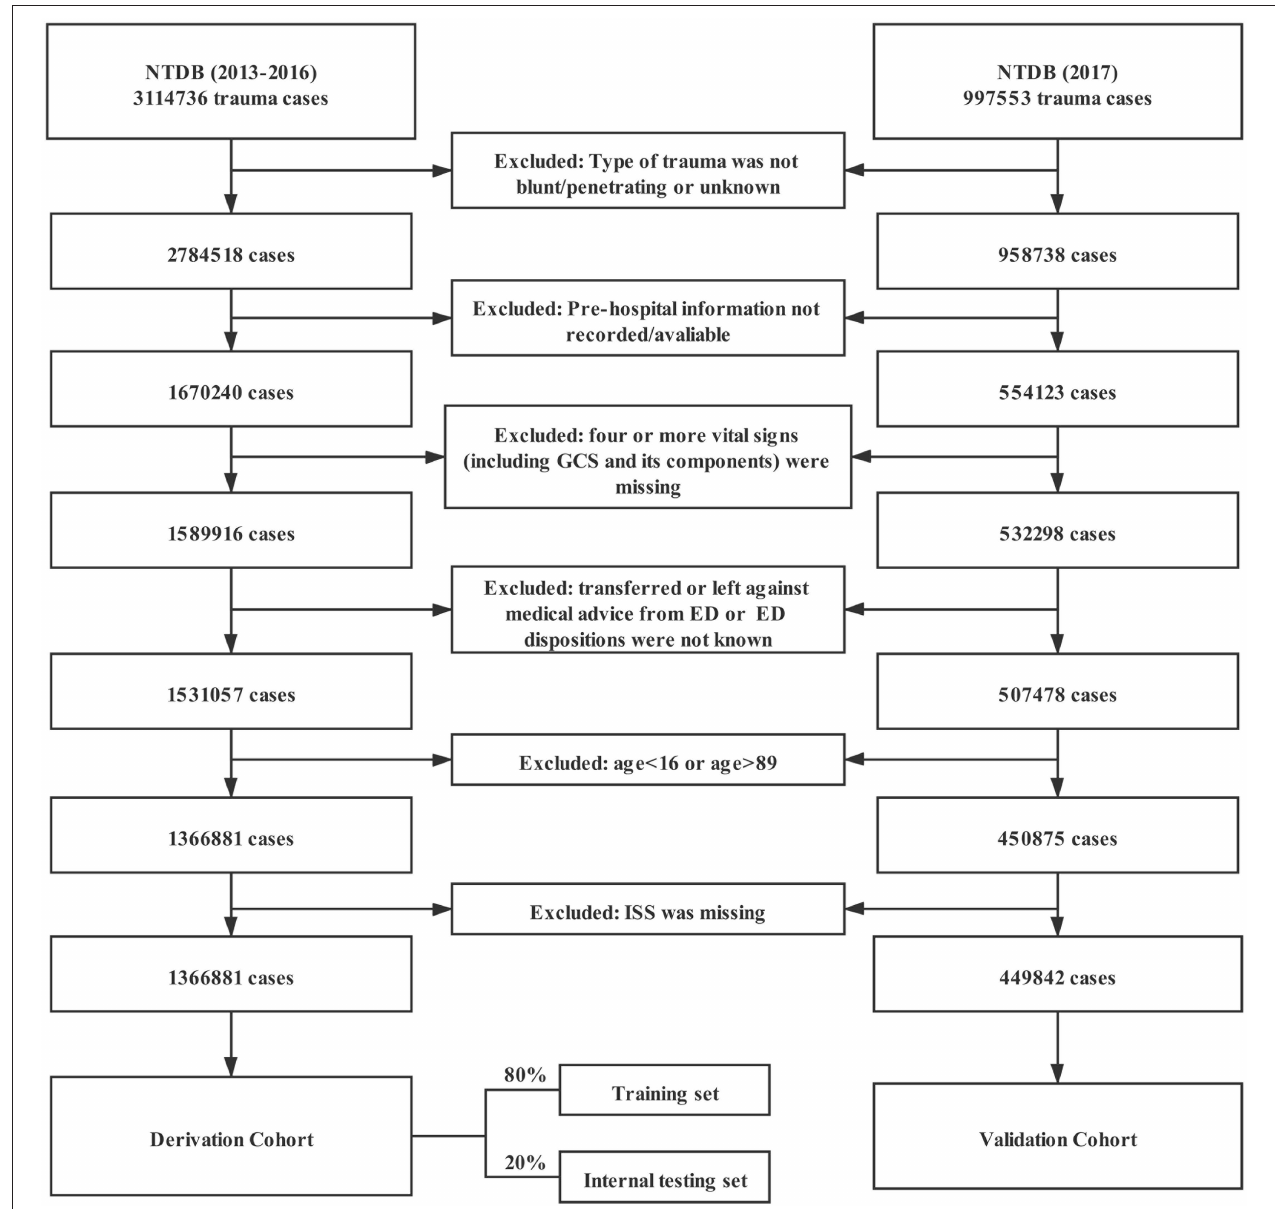
FIGURE 1 | Study participant selection procedure. NTDB , National Trauma Data Bank; GCS , Glasgow Coma Scale; ED , emergency department; and ISS , Injury Severity